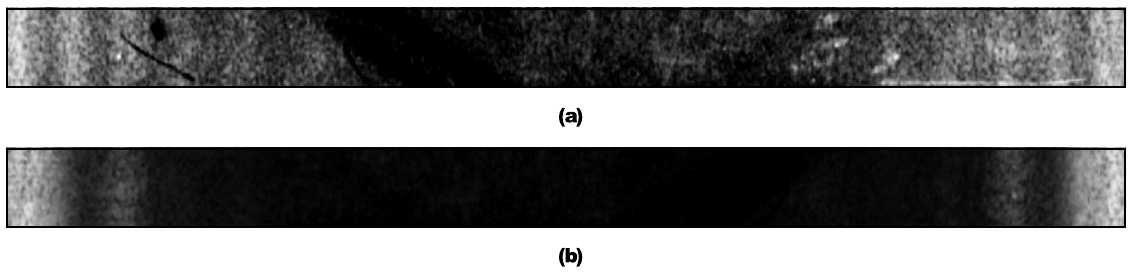
Figure 13. Holographic interferogram of vibrating MEMS, when fixed-fixed beam is performing: ( a ) periodic oscillations; ( b ) chaotic